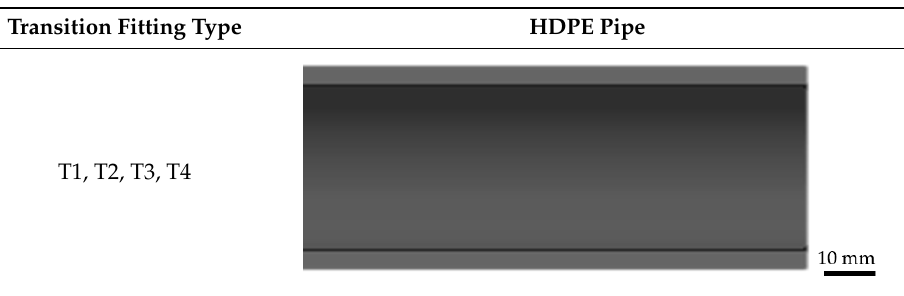
Table 8. Constructive shape of HDPE pipe.